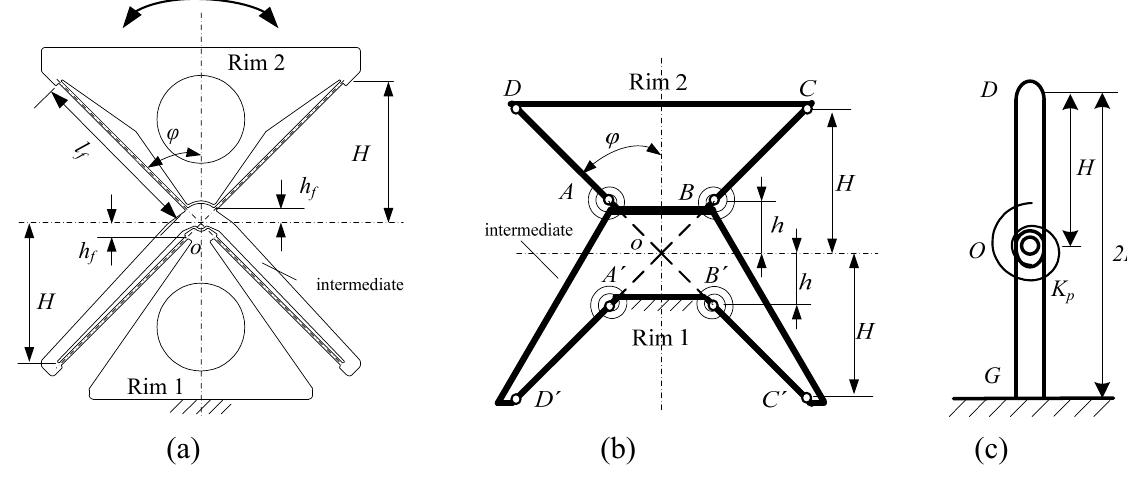
Fig.2 The PRB model of an ADLIF: (a) The ADLIF ; (b) The bar model; (c) The pin-joint model; Figure 2. The PRB model of an ADLIF: (a) the ADLIF; (b) the bar model; (c) the pin-joint